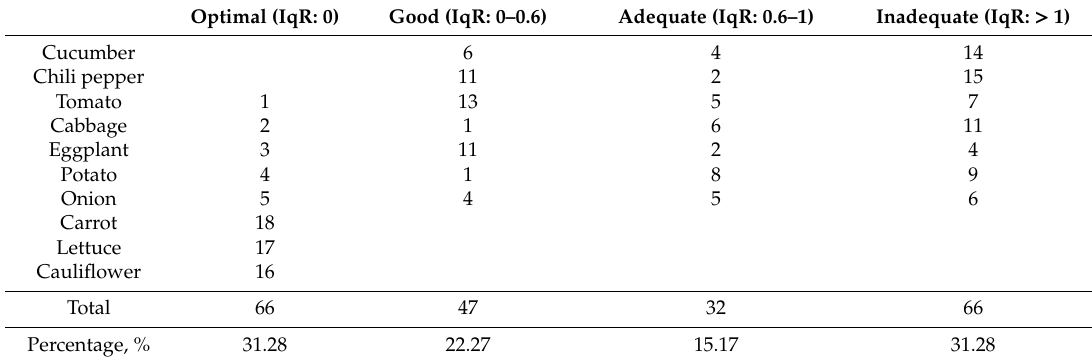
Table 5. The quality of the selected vegetables according to the calculated IqR.